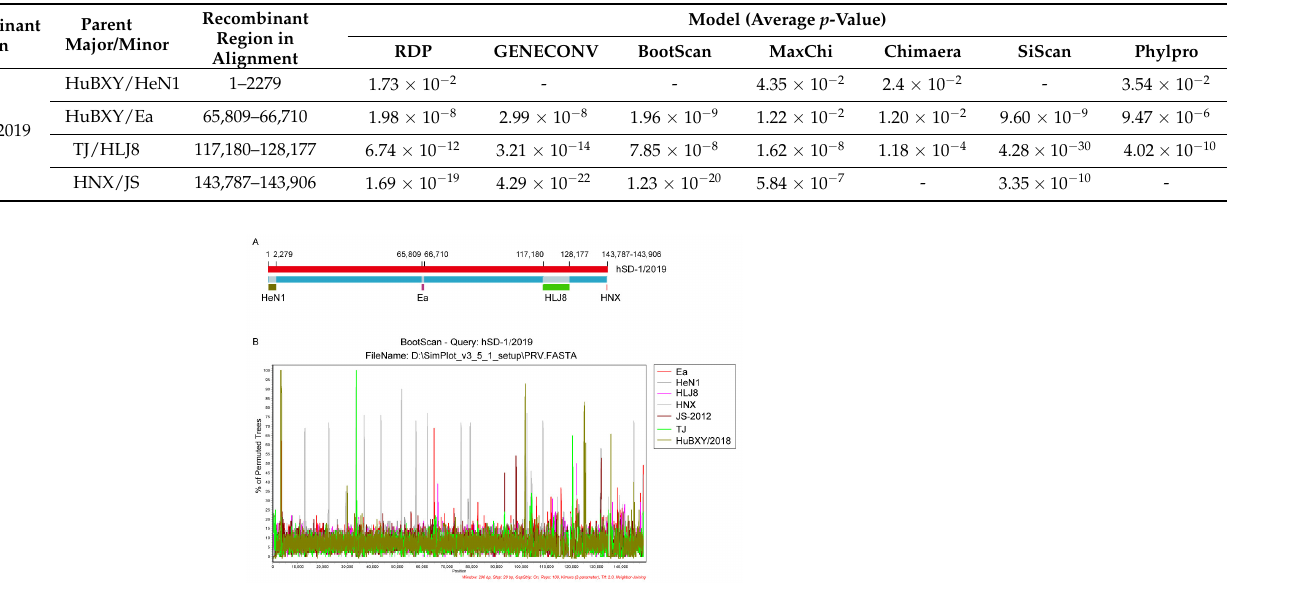
Figure 5. Genomic recombinant analyses of the complete genome of human-originated PRV strain hSD-1/2019 ( A ) Recombination events determined in the genome of hSD-1/2019. hSD-1/2019 genome are shown in red. The likely backbone is shown in blue. Recombination events predicted by RDP4 were shown as dark gold, purple, green, and red, respectively. Likely breakpoint positions were shown above the genome. ( B ) BootScan analysis of the complete genome sequence of hSD-1/2019. The complete genome sequence of hSD-1/2019 was used as the query sequence and compared with those of Ea, HeN1, HLJ8, HNX, JS-2012, TJ, and HuBXY/2018. The default setting of SimPlot software was used as follows: window size 200bp, step size